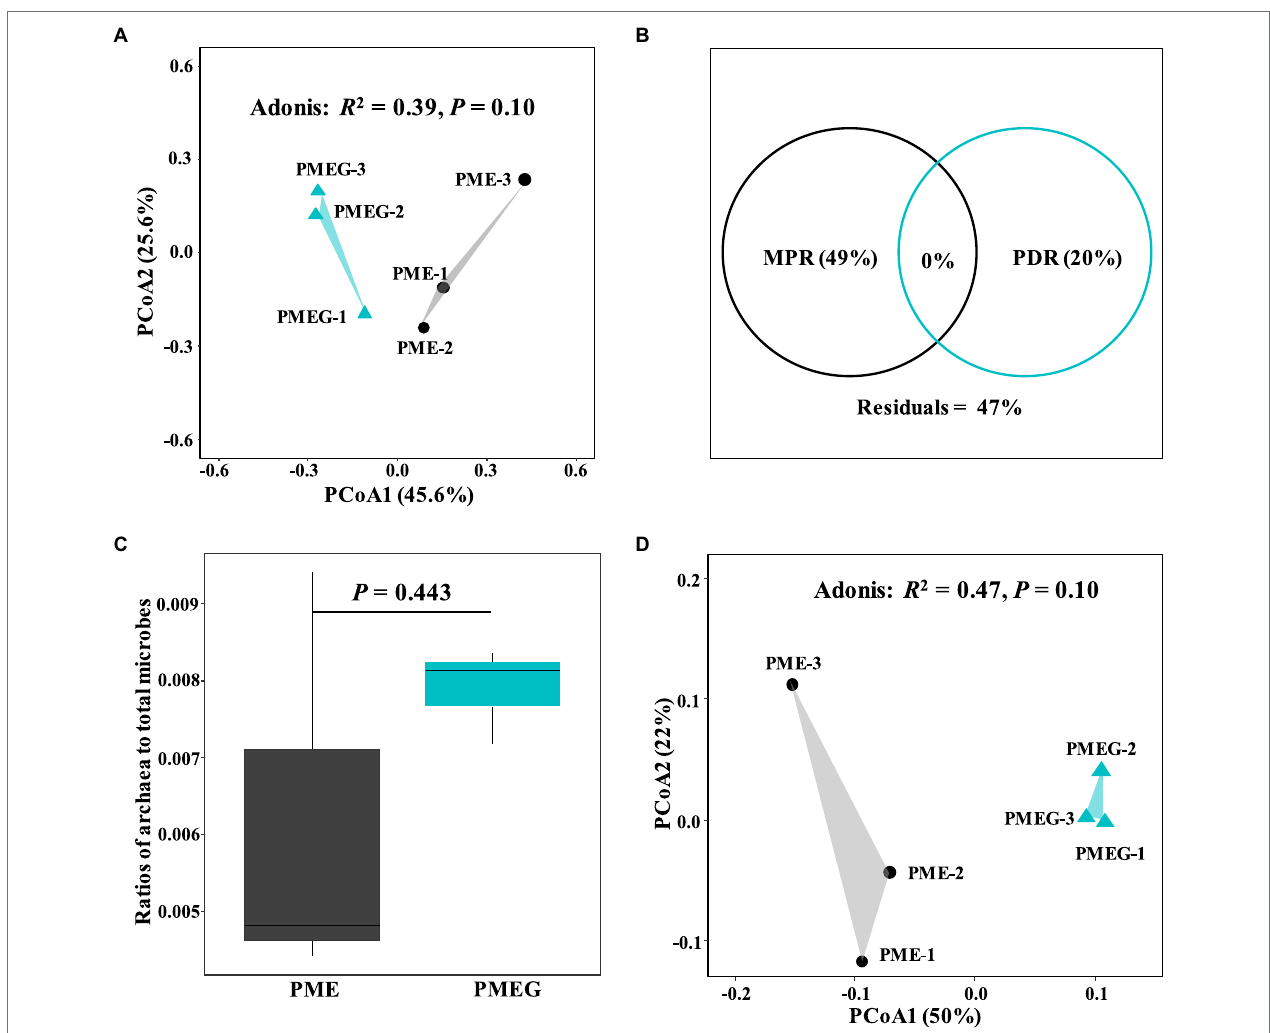
FIGURE 4 | The principal coordinate analysis (PCoA) profile based on the microbial species composition in the PME and PMEG treatments (A) and variance partitioning analysis showing the portions explained by MPR and PDR for the microbial community structure (B) ; the ratios of archaea to total microbes in the PME and PMEG treatments (C) and the PCoA profile based on the archaeal species composition in the PME and PMEG treatments (D) .